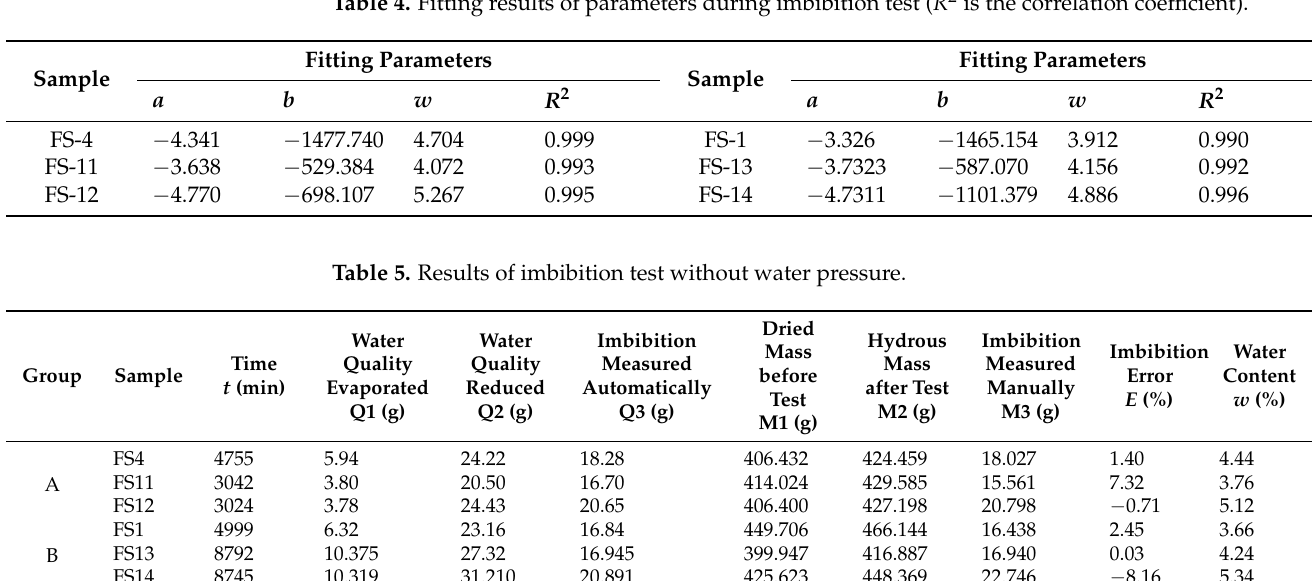
Table 5. Results of imbibition test without water pressure.